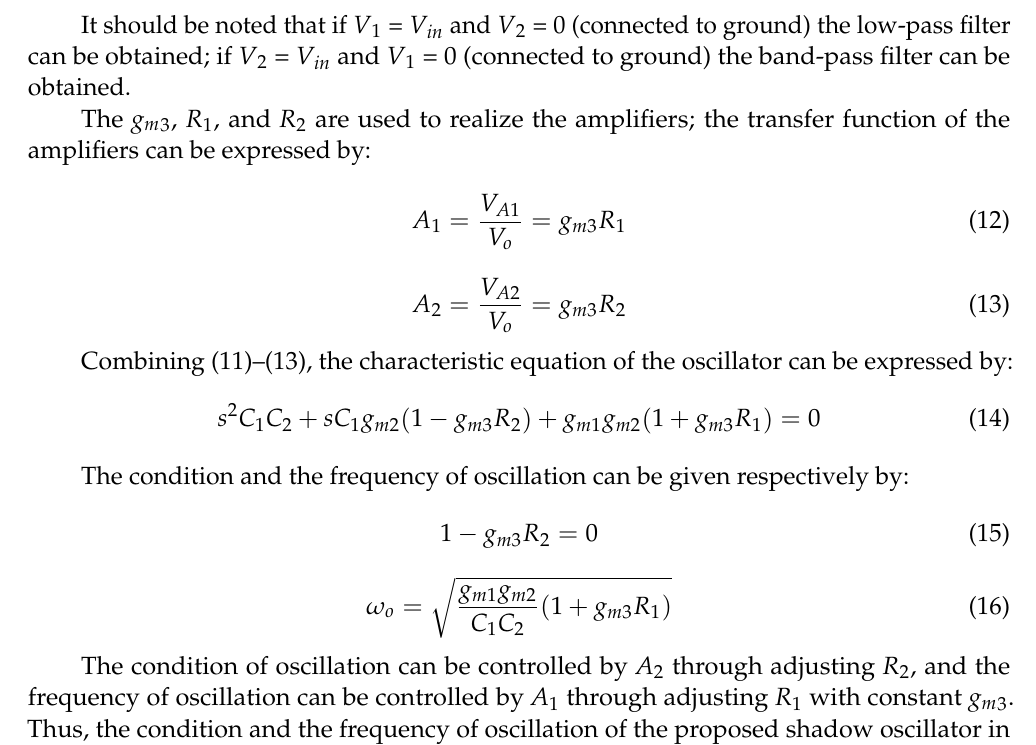
Figure 4. Proposed shadow oscillator using MI-OTA for ( a ) obtaining minimum number of MI-OTAs, and ( b ) obtaining electronic tuning capability.